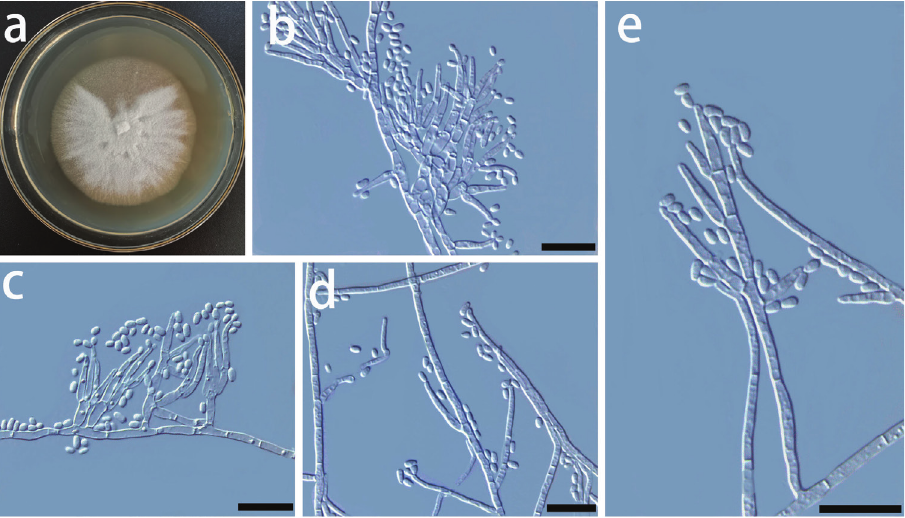
Figure 9. Morphological characters of asexual structures of Ceratocystiopsis yantaiensis sp. nov. a fourteen- day-old culture on MEA b, c type 1 conidiophores and conidia d-e type 2 conidiophores and conidia. – Scale bars: 10